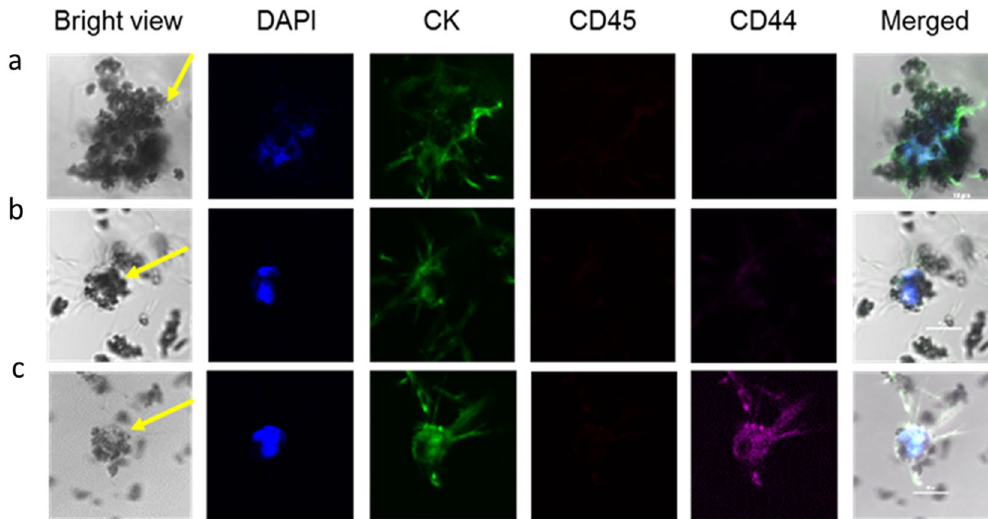
Figure 6. CTC captured and analyzed from lung cancer patient samples. An 8 mL blood sample (including anticoagulant) from each patient was collected for examination. Folate-Pro6-PEG12-biotin ligand-coated beads was used for patient sample analysis. Cell captured ligand-coated beads were stained and analyzed by immunofluorescence. Immunofluorescence staining of cell surface receptors of a captured a) CTC cluster, b) single CTC and c) stem cell like CTC from a lung cancer patient. The images shown staining included Cytokeratin (CK, green), CD45 (red), CD44 (purple), and DAPI (blue). The scale bar is 20